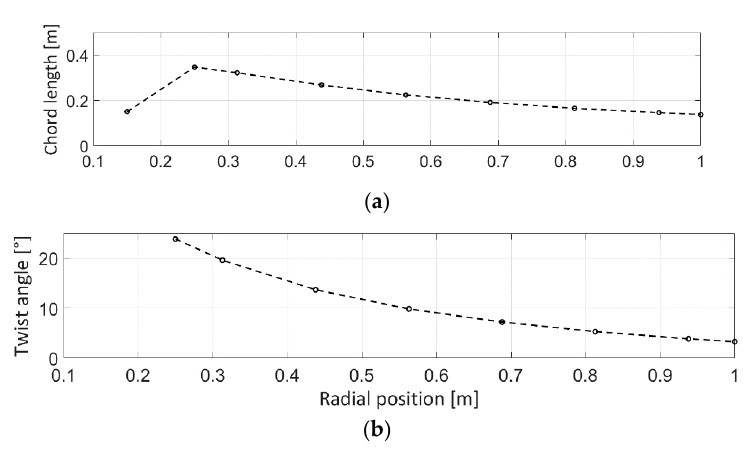
Figure 3. ( a ) Chord and ( b ) twist angle distribution.